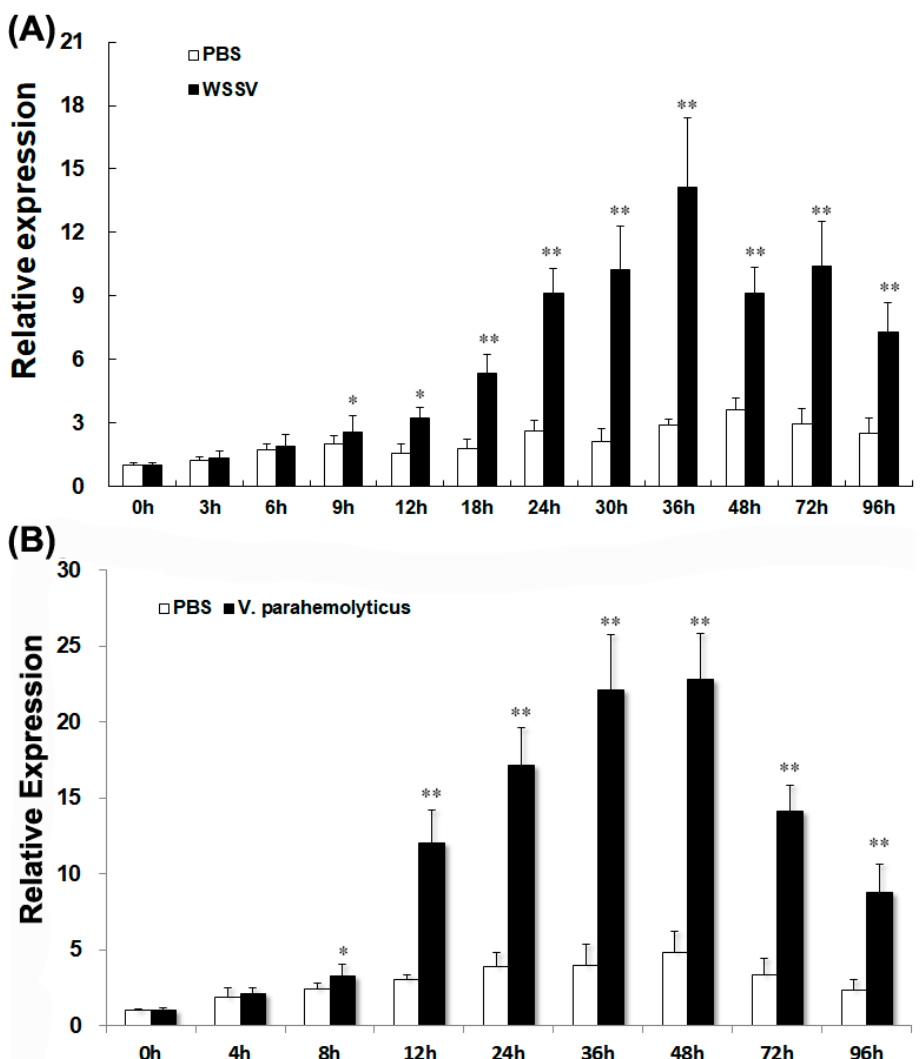
Figure 5. Expression of LvGPX3 in hemocytes of immune-challenged shrimps. The mRNAs were collected at 0, 3, 6, 9, 12, 24, 30, 36, 48, 72 and 96 h after WSSV infection ( A ), or at 0, 4, 8, 12, 24, 36, 48, 72 and 96 h after V. alginolyticus infection ( B ). The relative expression of LvGPX3 upon WSSV or V. alginolyticus infection was normalized with LvEF1 α and compared to time zero. The bars represent the mean values ± S.D. of three replicates. The statistical significance was calculated using Student’s t -test (* indicates p < 0.05; ** indicates p < 0.01).